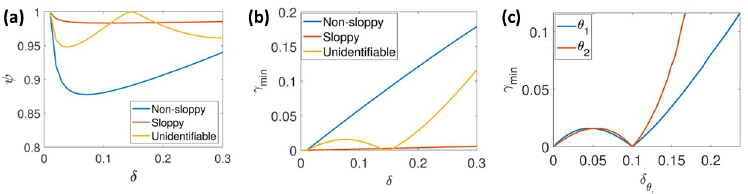
Fig 5. Visual sensitivity analysis plot. (a) shows the model sensitivity plot for all three regions; for the non-sloppy region, the curve deviates from the unity value for the given δ , indicating local structural identifiability. The curve is very close to the unity value for the slope region, indicating an-isotropic sensitivity/ multi-scale sloppiness. The curve numerically hits unity for the unidentifiable region, indicating local structural unidentifiability for the given δ . (b) shows the γ m in vs δ plot for all three regions; for the non-sloppy region, the γ min is numerically significant and has a constant slope for given δ . For sloppy region, γ is numerically insignificant for a significantly large δ . The slope of min the curve is constant, but the value of the slope is numerically closer to the zero value indicating a sloppy region in the given δ . The curve numerically hits zero value respectively at δ = 0.14 indicating a local structural unidentifiability. (c) Shows γ vs d for unidentifiable region, in this case both the γ is zero for non-zero d indicating local structural min min y i y i unidentifibility for both the